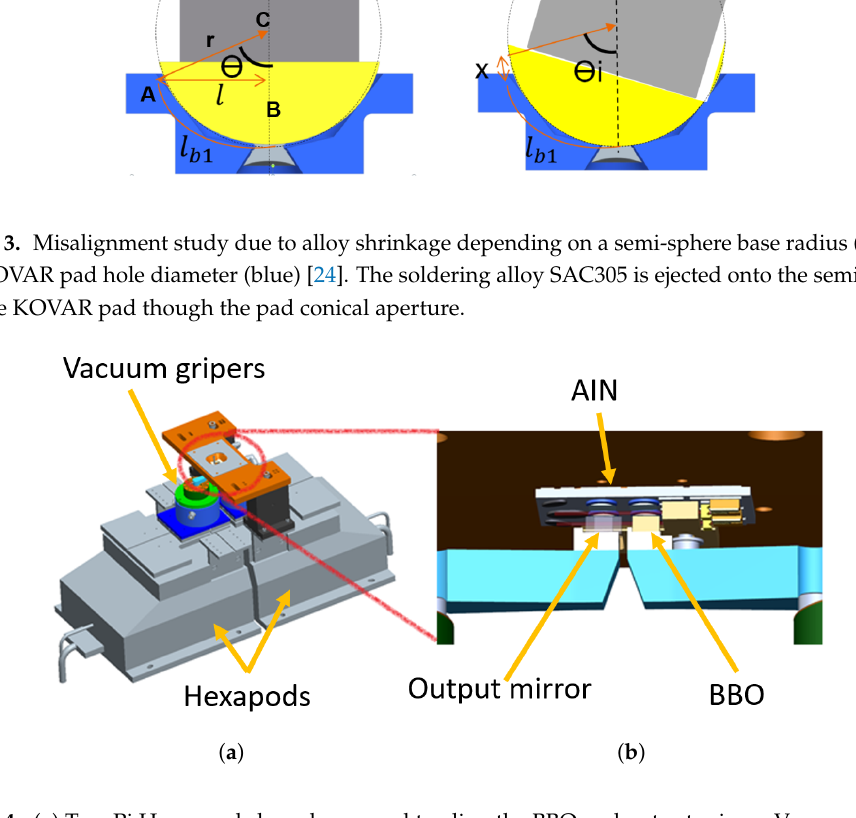
Figure 4. ( a ) Two Pi Hexoapods have been used to align the BBO and output mirror. Vacuum gripers were used for that purpose. ( b ) Detailed image with the two components being positioned after the Nd:YAG and on their respective KOVAR pads.